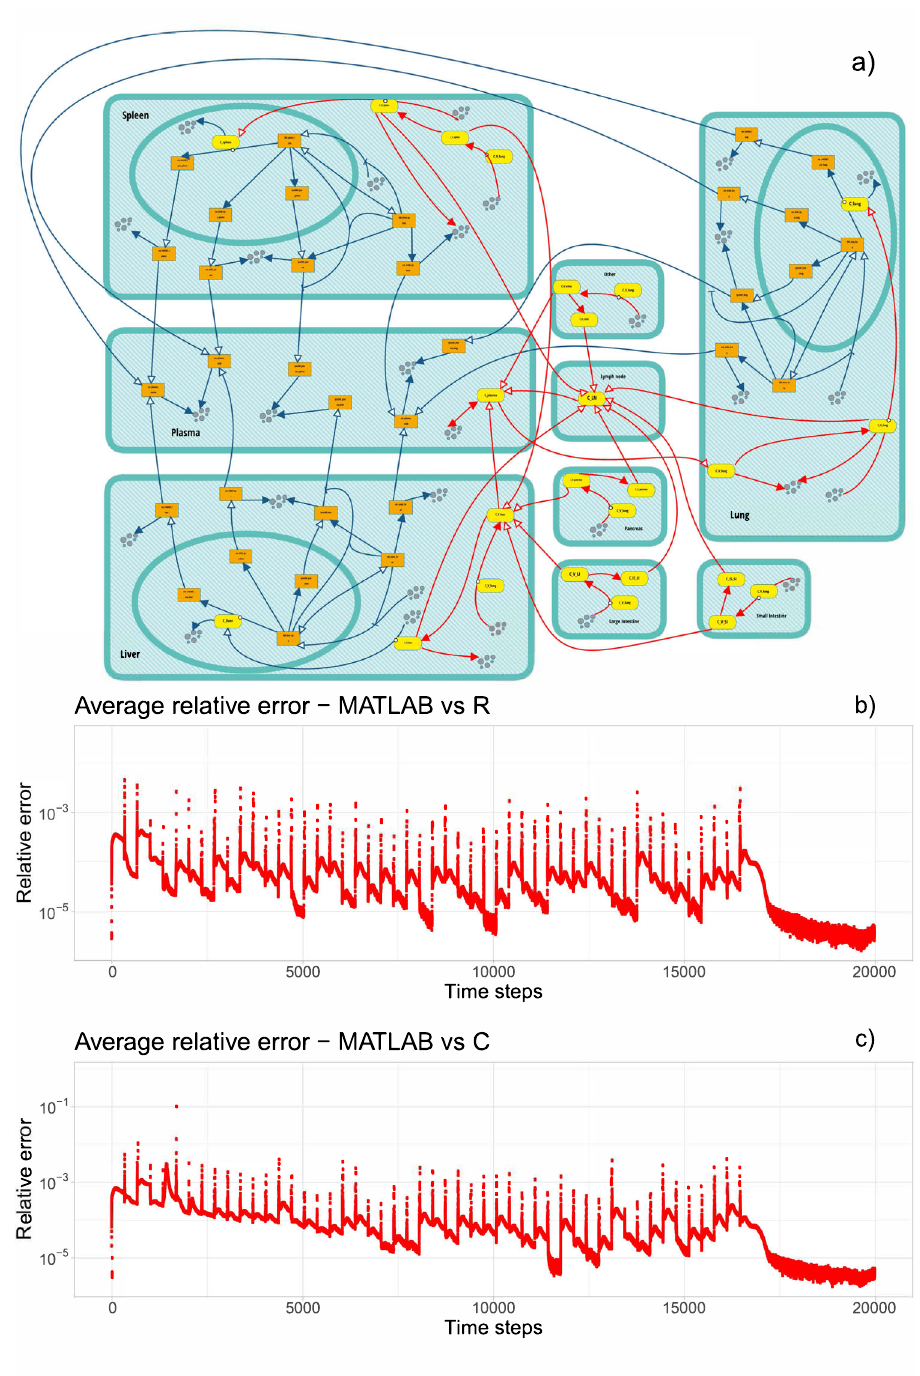
Fig. 3 Model diagram of the acid sphingomyelinase de fi ciency (ASMD) with QSPcc model translation simulation accuracy. ASMD is a rare lysosomal storage disorder, here modeled treated with the investigational olipudase alfa enzyme replacement therapy. a ASMD model represented as a biological pathway in the bStyle environment 21 . b Relative error for each time step of integration, averaged over all variables of the target R model compared to the source MATLAB model. c Relative error for each time step of integration, averaged over all variables of the target C model compared to the source MATLAB